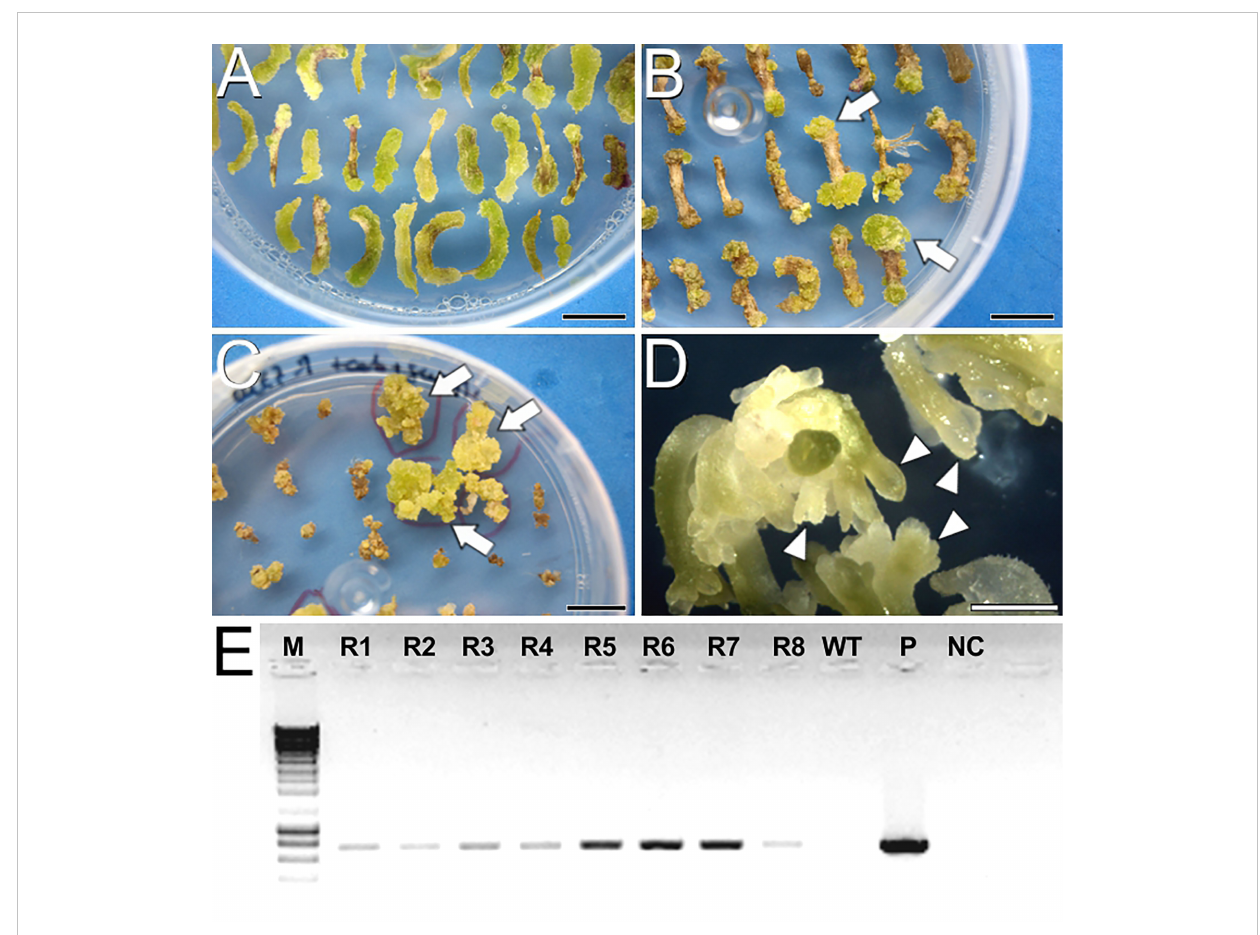
FIGURE 1 Carrot transformation and regeneration using protocol E. (A) Hypocotyl explants after 15 days in Selection 1 medium. (B) Hypocotyl explants after one month in Selection 2 medium. Arrows point to green, growing calli resistant to the selective agents. (C) Calli after one month in EIM with selective agents. (D) Full embryos developed in solid MS2% medium. Arrowheads point to developing somatic embryos. (E) Agarose electrophoresis gel showing PCR ampli fi cation of the transgene. From left to right, M, DNA molecular weight marker; R1-R8, Eight plantlets regenerated from the four resistant calli; WT, Wild type plant; P, PM-YC3.6-LTI6b plasmid; NC, PCR negative control. Bars: (A-C) : 1 cm; D: 1